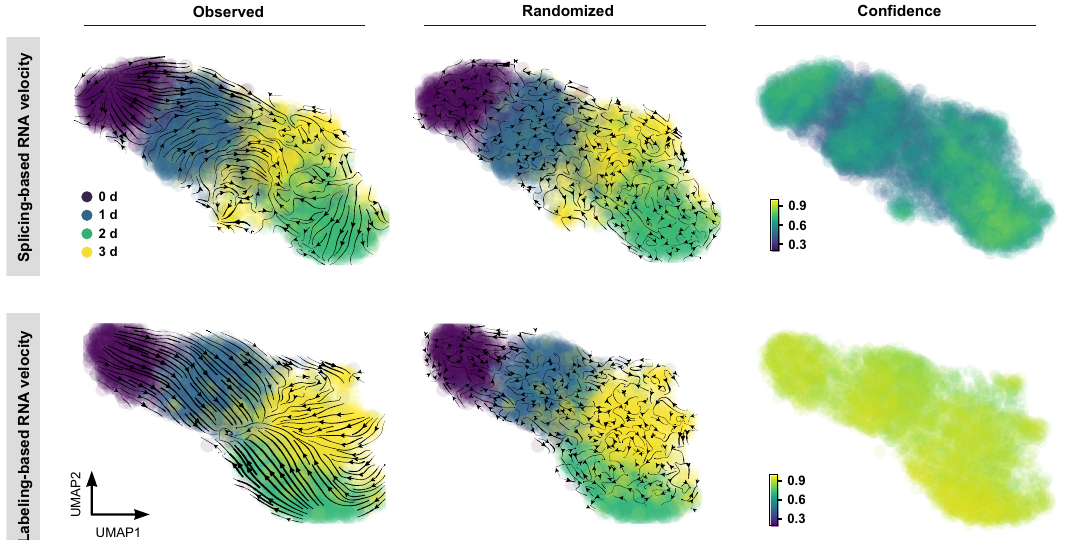
Fig. 5 | Metabolic labeling-based RNA velocity analysis of HCT116 cells in response to 5-AZA-CdR treatment. UMAP visualization of HCT116 cells treated with5-AZA-CdRfor0/1/2/3dcharacterizedbyconventionalsplicing-based(upper- left)or metaboliclabeling-based(lower-left) RNA velocity analysis. Cells are color- coded by treatment time. The streamlines reveal the integration paths of local projections moving from the observed state to the extrapolated future state. The